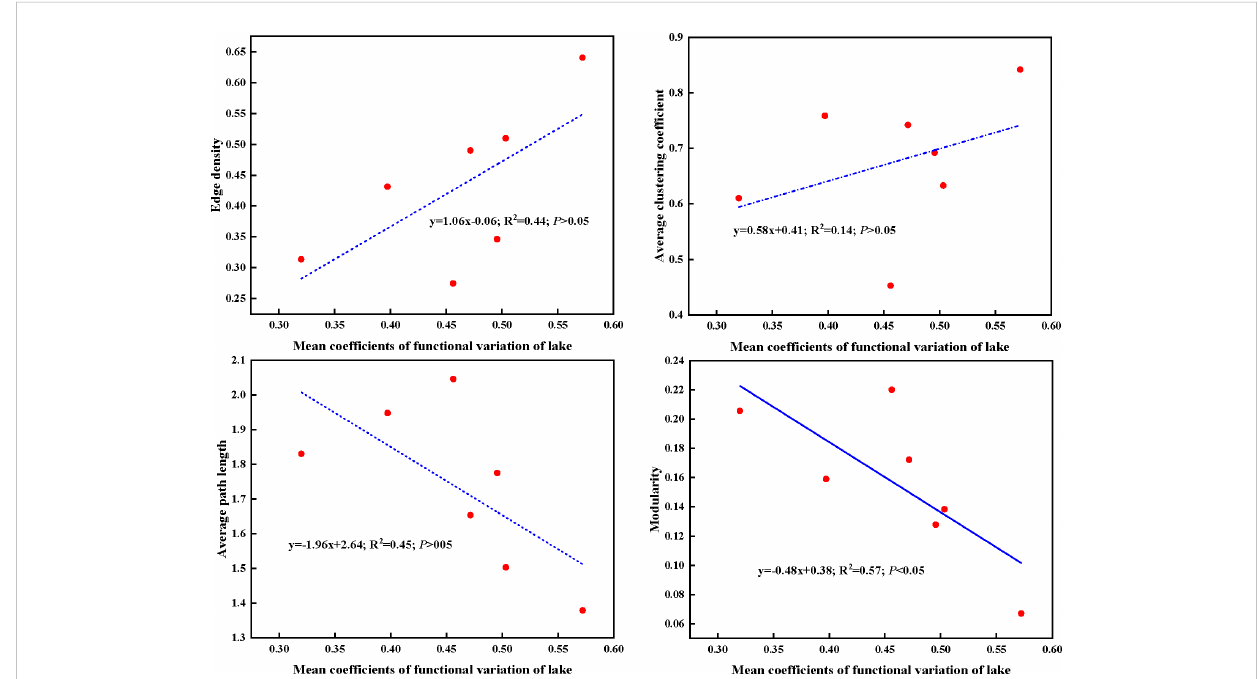
FIGURE 8 Linear regressions between mean coef fi cients of functional traits variation of lake and plant trait network parameters. Dashed lines indicate that the slope of the linear regression is nonsigni fi